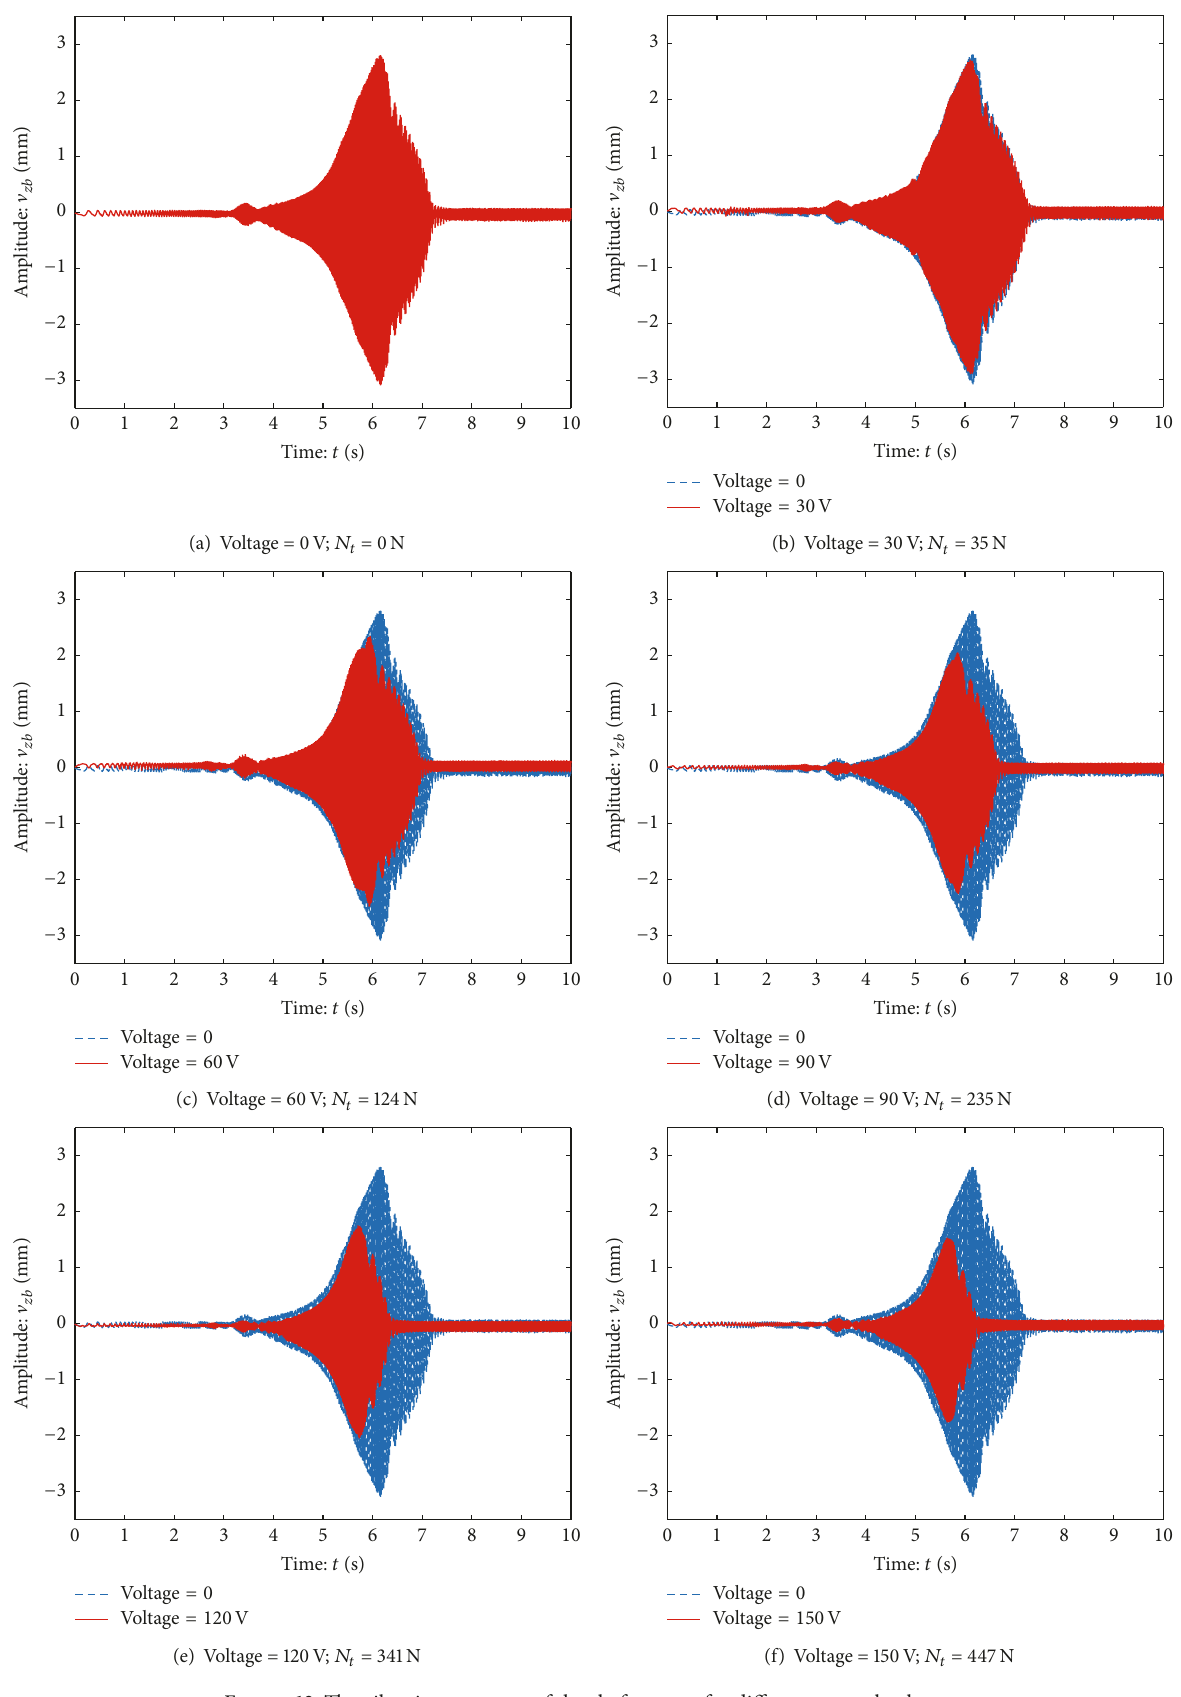
Figure 12: The vibration response of the shaft system for different control